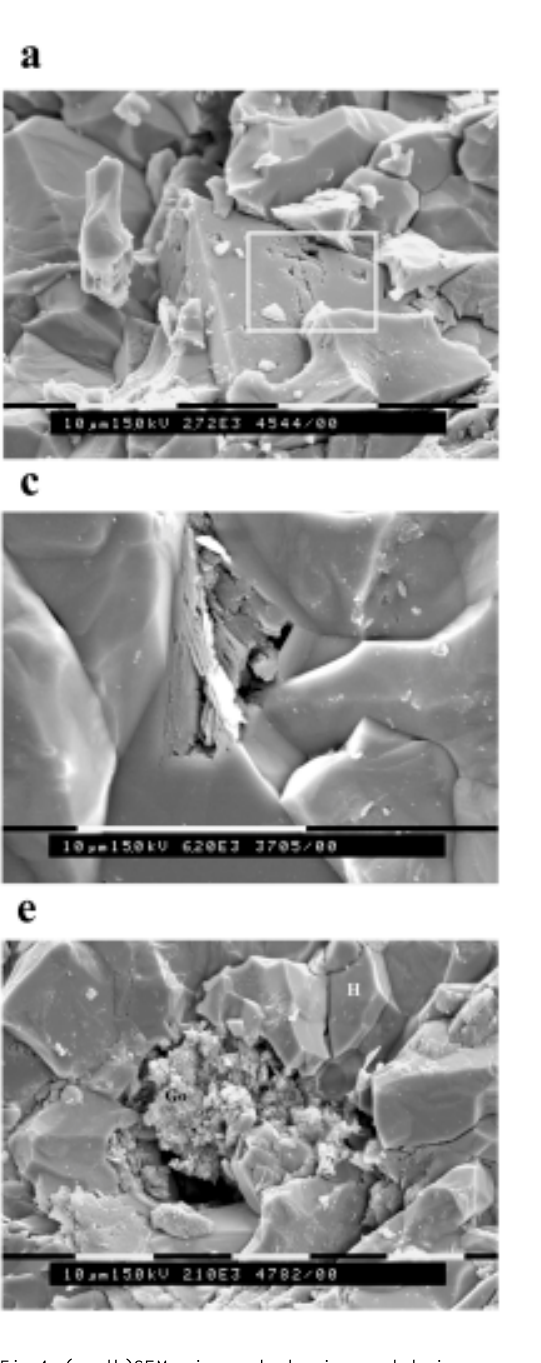
An. Acad. Bras. Cienc. ,(2002) 74